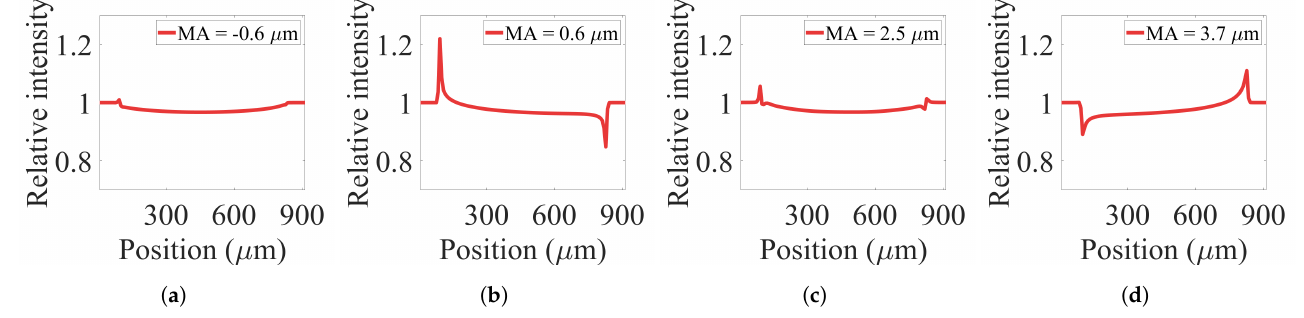
Figure 13. ( a – d ) Illustration of simulation results of the effect of environmental vibration on the performance of an EI-XPCi system with pixel size equal to 7.8 µ m × 7.8 µ m. The behavior of the system dramatically changes even with less than one micrometre shift in the mask